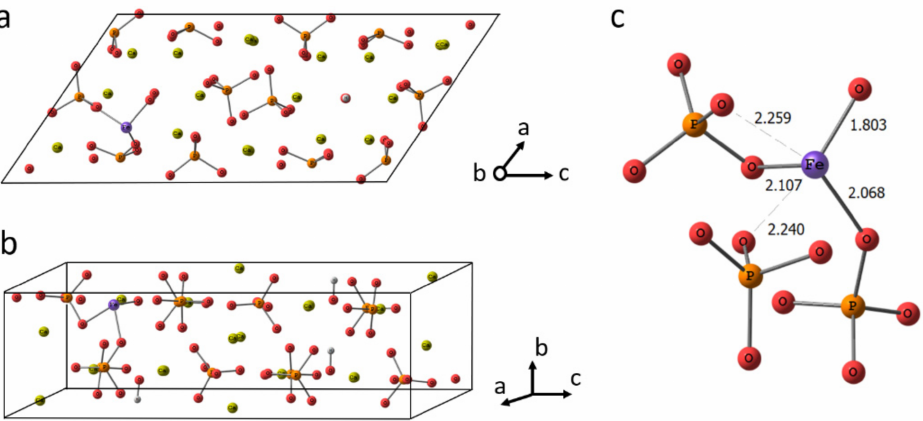
Figure 9. The crystalline cell of HA doped with Fe 3+ in Ca(2) position ( a , b ). The fragment of the cell showing Fe 3+ coordination ( c ).